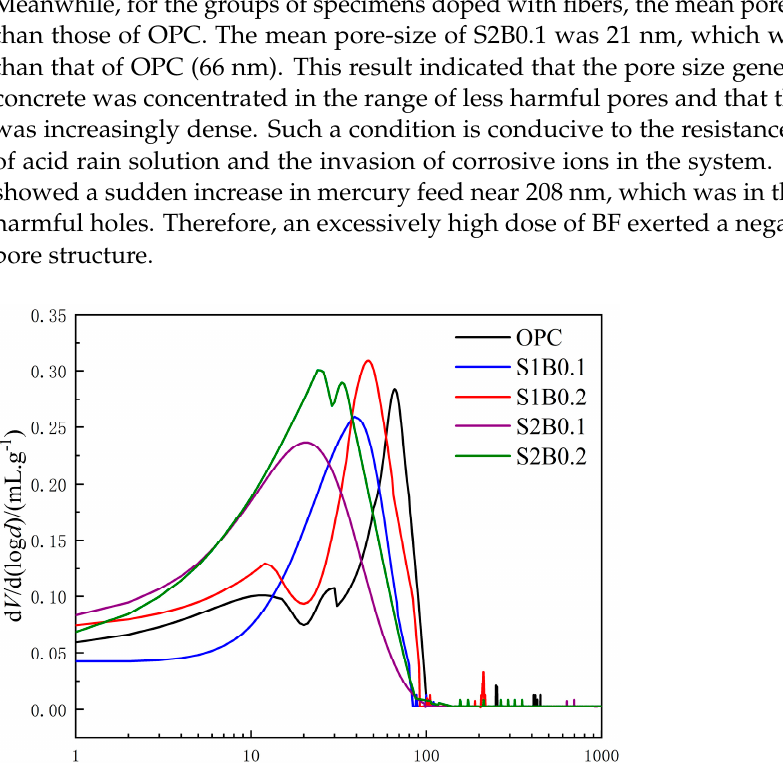
Figure 8. Pore size differential distribution curve of fiber concrete under an acid rain